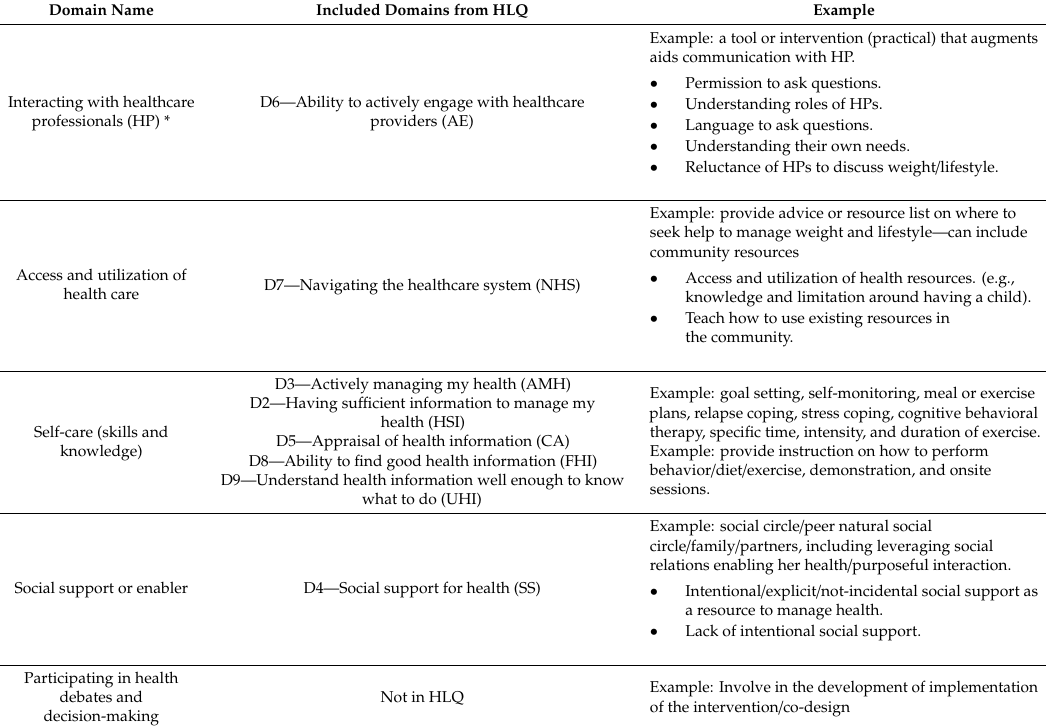
Table 1. Definitions of health literacy lifestyle intervention